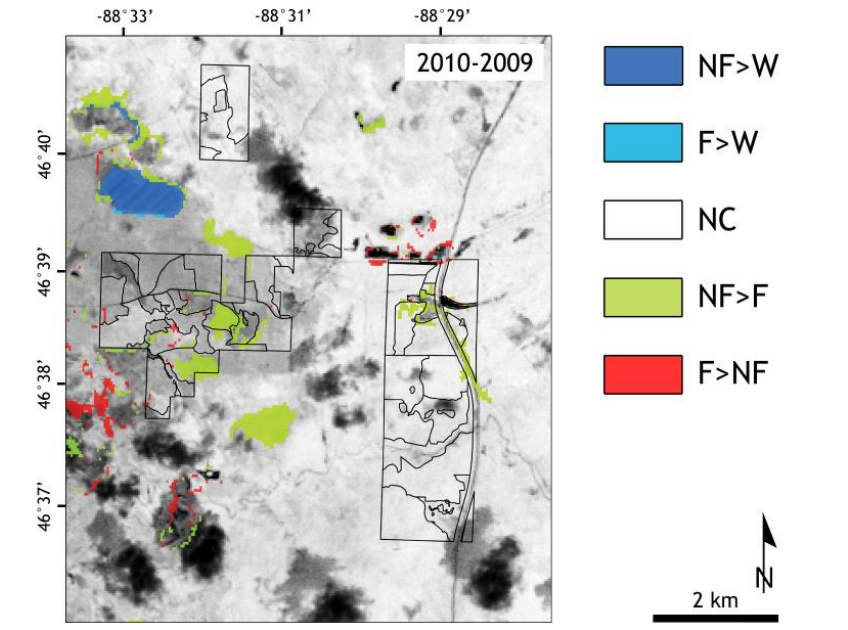
Figure 6. Difference of FNF classification in 2009 and 2010 at the FFC overlaid onto the 2010 NDVI image. Classes: non-forest to water (NF > W), forest > water (F > W), no change (NC), non-forest to forest (NF > F), forest to non-forest (F >